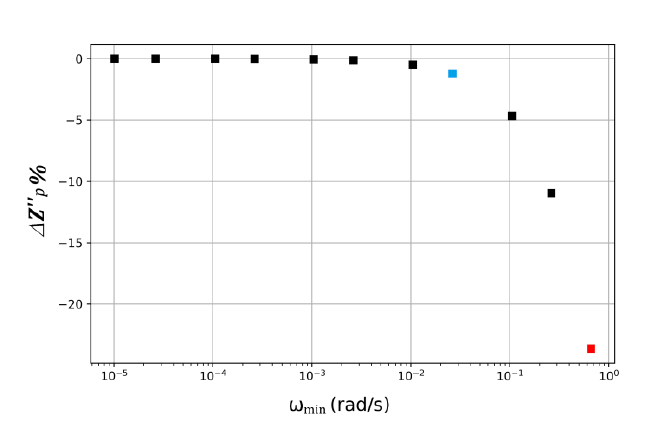
Fig.7: Percentage change of 𝑍′′ 𝑝 ( ∆𝑍′′ 𝑝 % ) versus 𝜔 𝑚𝑖𝑛 . Red point: case without extrapolation (figure 4). Blue point: ∆𝑍′′ 𝑝 % = −1